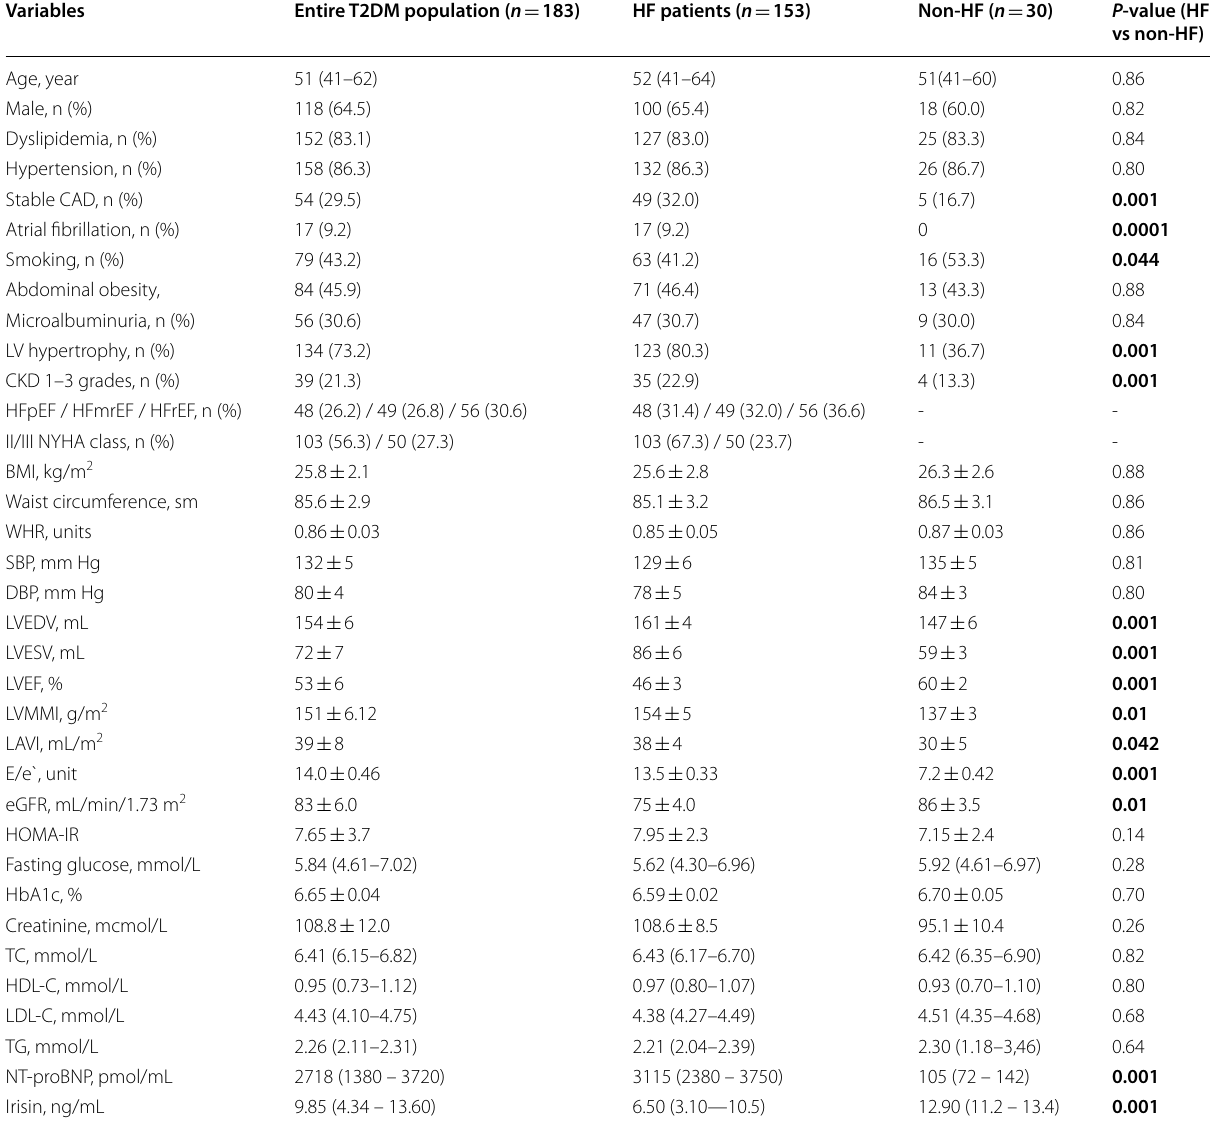
Table 1 Characteristics of the study patient